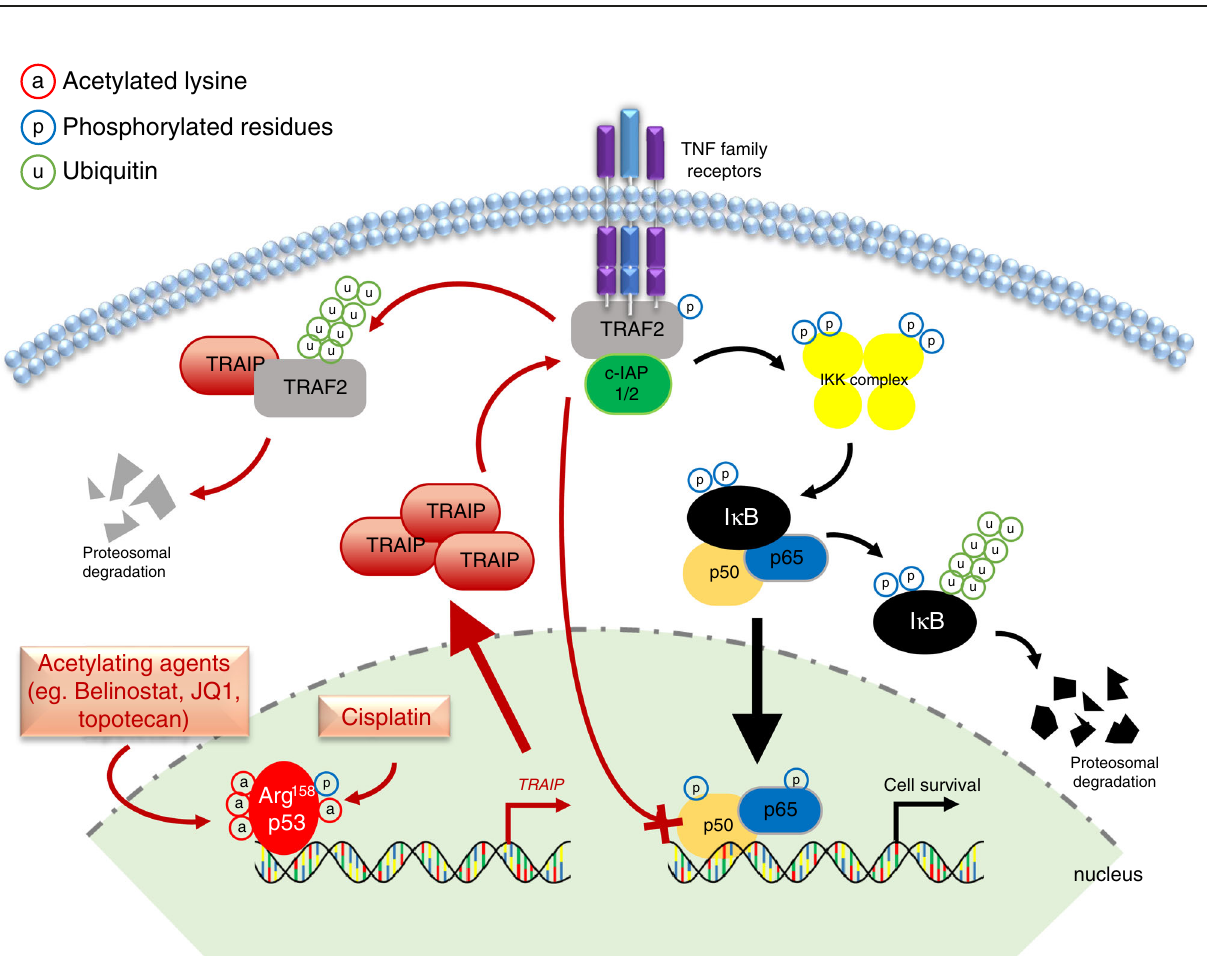
Fig. 7 Cisplatin, JQ1 and topotecan reduce tumor growth in PDX models harboring Arg 158 p53 mutations. a – f Ef fi cacy of cisplatin, JQ1 and topotecan were investigated in PDX model of gastric cancer (GC) and hepatocellular (HCC) cancer. Growth curve analysis of GC-PDX ( a ) and HCC-PDX ( d ) treated with vehicle, cisplatin (CDDP; 4 mg kg − 1 ), JQ1 (30 mg kg − 1 ), or topotecan (1 mg kg − 1 ). Tumor sizes are presented as mean ± SEM. Two-way ANOVA with Bonferroni correction; * P < 0.05; ** P < 0.01; *** P < 0.001. Waterfall plots showing change in tumor volume (relative to initial tumor volume at treatment- start day) for each individual GC-PDX ( b ) and HCC-PDX ( e ) tumor in respective treatment group. Bodyweight of mice with GC-PDX ( c ) and HCC-PDX ( f ) at assay endpoint was tabulated as mean ± SD. g Western blots demonstrating changes of the indicated proteins in tumors of respective treatment ( n = 3 independent tumors). β -actin shown as loading control. Densitometric quanti fi cation of TRAIP expression was tabulated on the right. Relative fold change is normalized to β -actin, relative to vehicle control tumors. Data presented as mean ± SD. Two tailed Student ’ s t -test; * P < 0.05, ** P < 0.01. h – i RNA in situ hybridization (RNAscope) showing TRAIP expression in respective tumors. Representative images showing TRAIP mRNA signal are shown at ×20